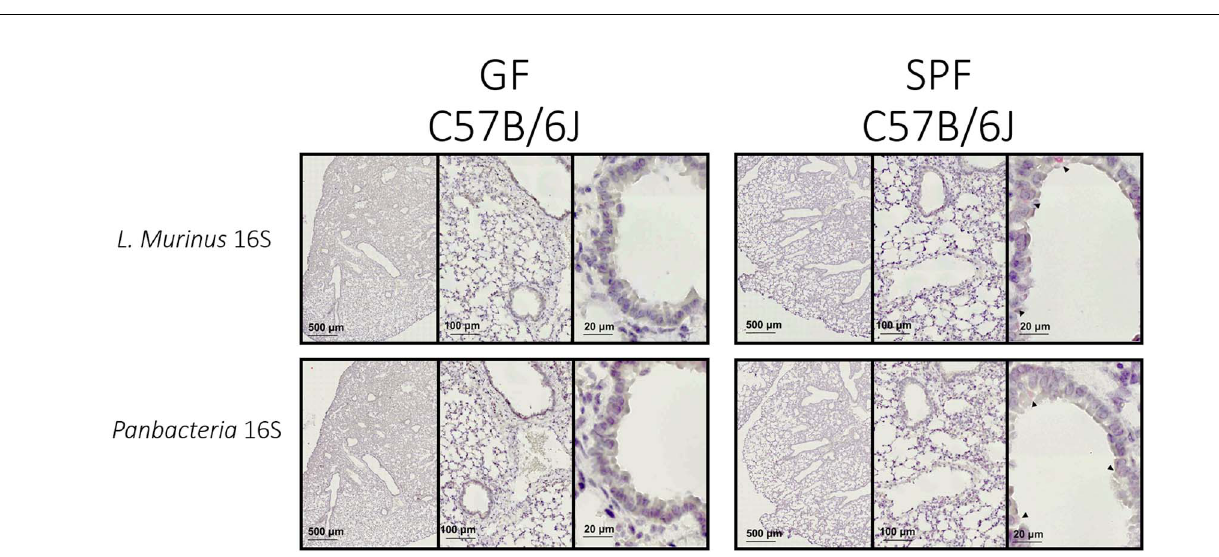
FIGURE 4 | L. murinus and panbacteria visualization in lung sections of SPF and GF mice—Sections obtained by performing transversal cuts of whole lung and visualized under a brightfield microscope with a 100 × /1.4 Oil objective. Black arrows indicate the presence of target RNA: L. murinus (top panel) or Panbacteria (lower